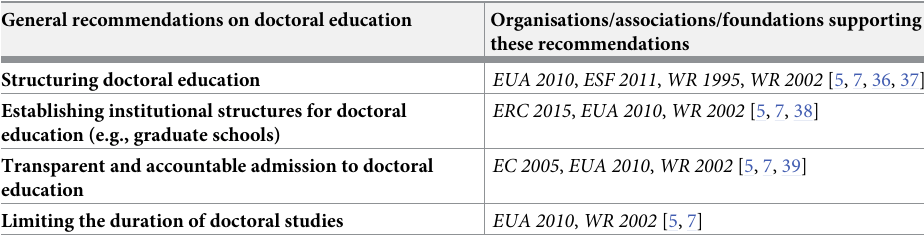
Table 1. General recommendations on doctoral